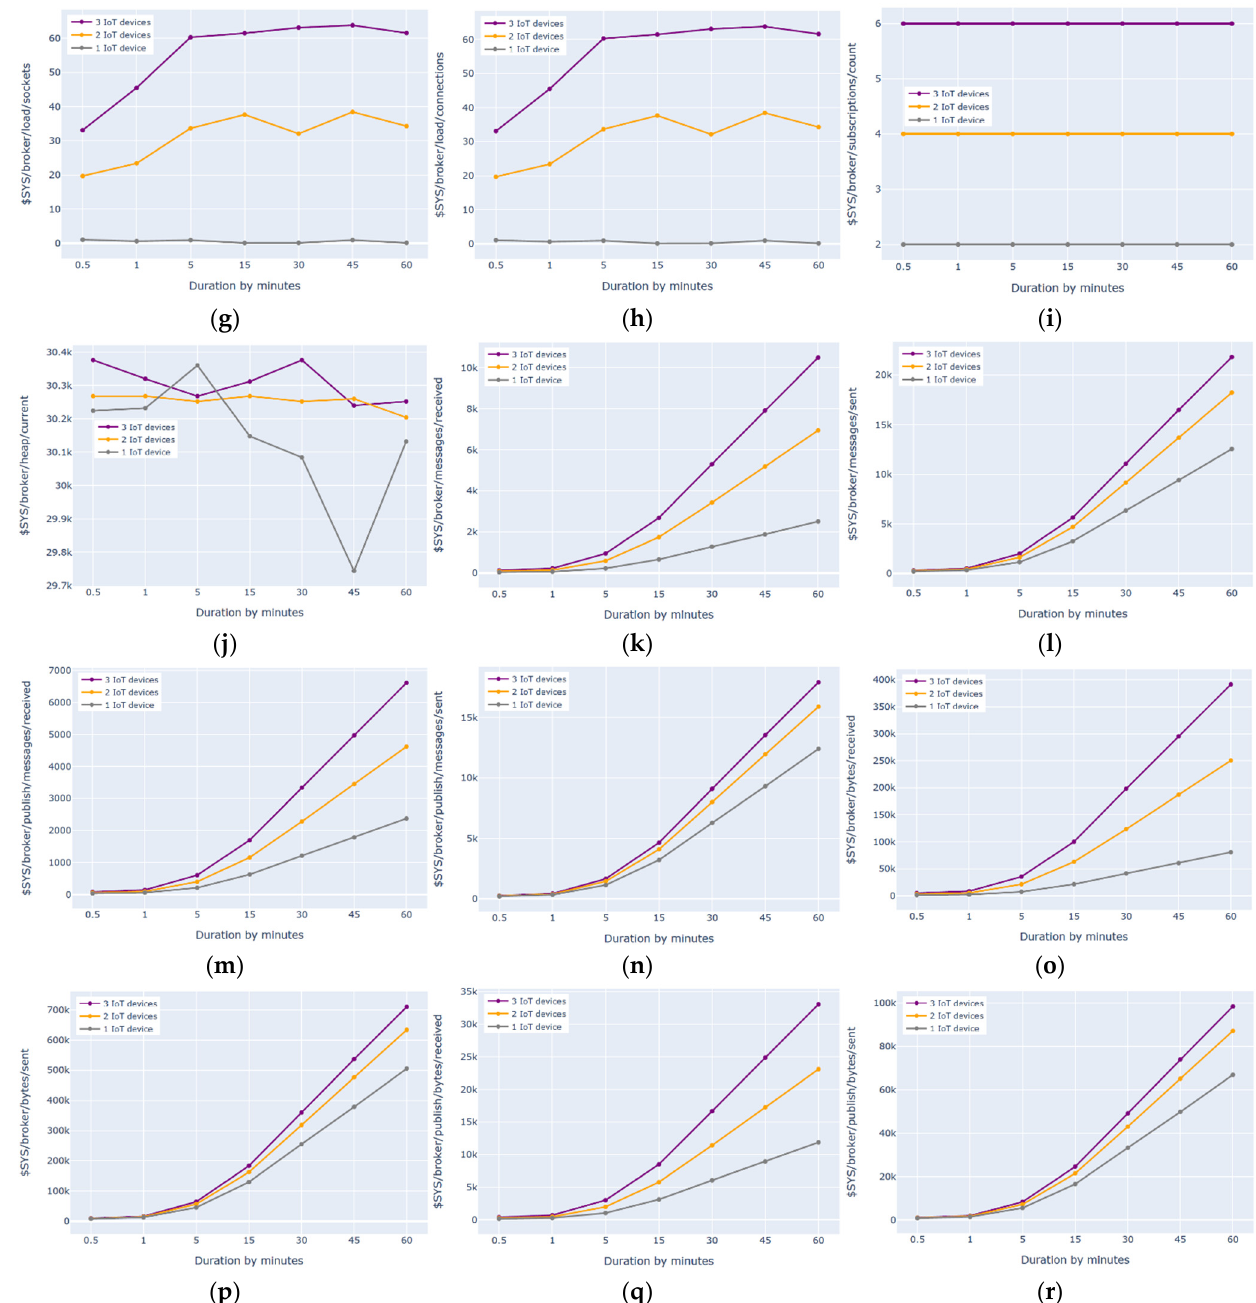
Figure 14. Mosquitto message broker metrics on the fog layer using bridge (Architecture 1).